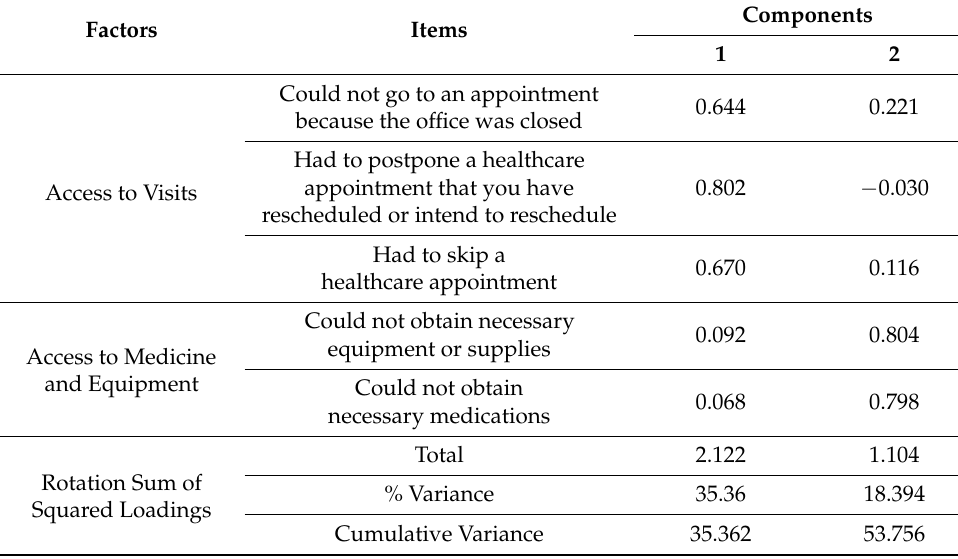
Table 1. Factor analysis of the access to healthcare measures.